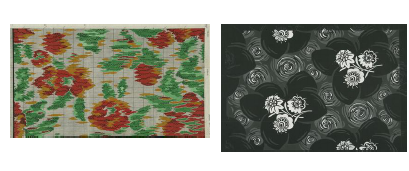
Figure 3. Examples for images of fabrics we used for our work. Classes: 2nd half 19th century, Catalonia, Jacquard. c (cid:13) Quico Ortega (IMATEX, 2018)